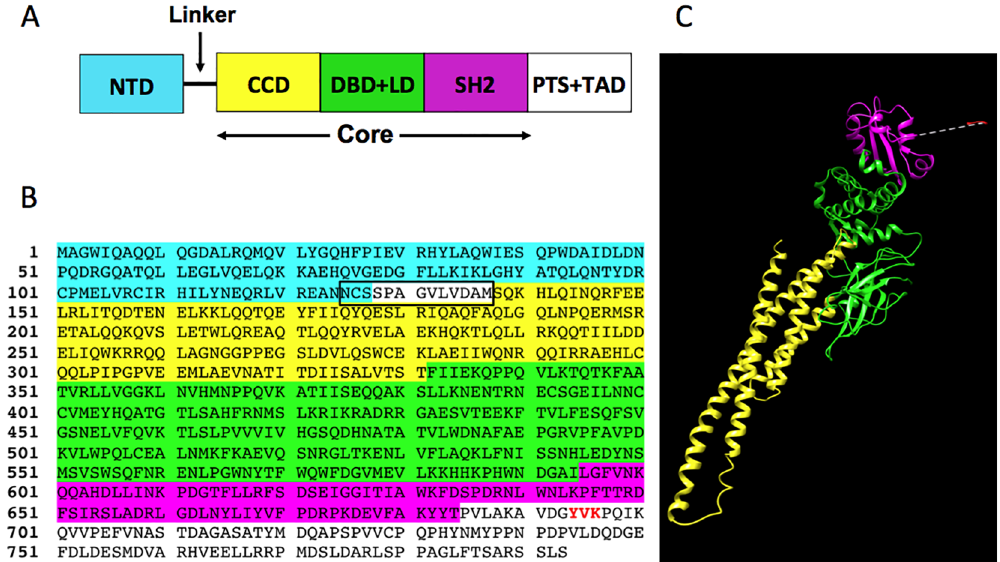
Fig 1. The domain structure of STAT proteins. (A) Names and positions of the six domains on the primary sequence: NTD (N-terminal domain), CCD (4-helix bundle coiled-coil domain), DBD (DNA-binding domain), LD (linker or connector domain), SH2, and TAD (transactivation domain). We treated the DBD and LD as one combined domain, as SCOP [17] does for STAT3 β . There is a short flexible 13-residue linker between the NTD and CCD, which partly overlaps with the NTD. There is also a phospho-tyrosine containing segment (PTS) between the SH2 and TAD, which we combined with the TAD. See Methods for more detail. ( B) The sequence of mouse STAT5A (NCBI Accn# CAA88419.1). The residues are highlighted according to the domains to which they belong, using the same coloring scheme used in (A). The 13-residue linker is boxed. The phospho-tyrosine residue (Y694) and the two following residues (V695 and K696) are shown in red. (C) STAT5A domains in the modeled structure of the STAT5A core, which includes the CCD, DBD, LD, SH2 and the residues 694 – 696 of the PTS. Dotted line represents the connecting residues (685 – 693) that were not included in the